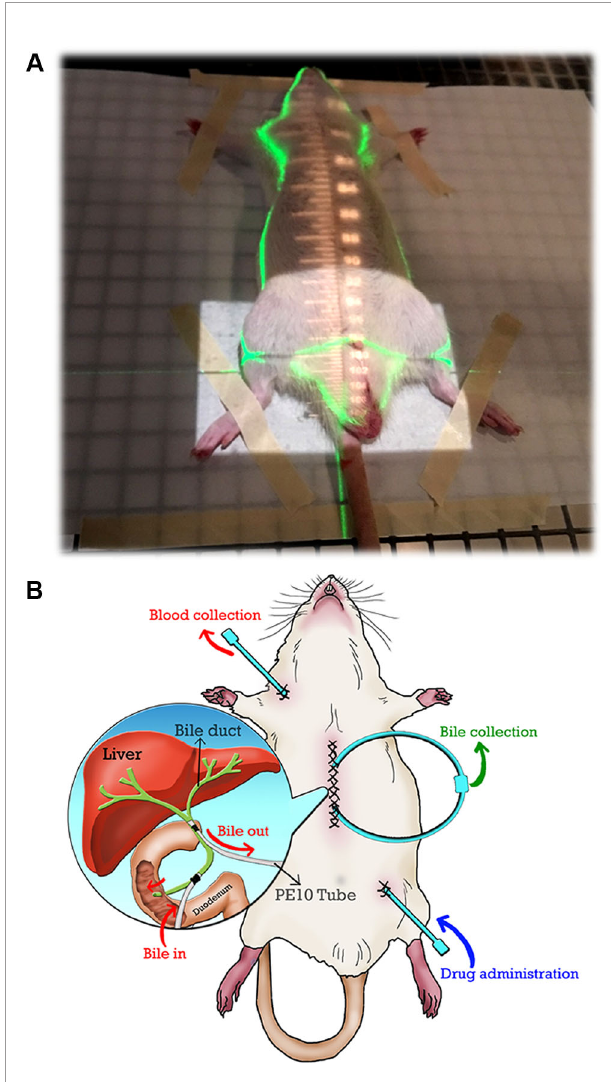
FIGURE 1 | (A) The irradiation fi eld of the whole pelvis. The cranial margin was set at the top of the bilateral iliac crest for the whole pelvic fi